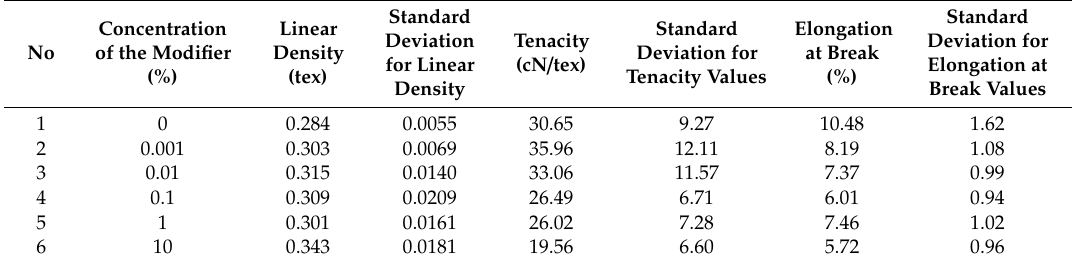
Table 1. Mechanical properties of fibers modified with luminescent polymer poly((9-carbazolyl)methylthiirane) (KMT). Standard Concentration Linear Standard Deviation Tenacity No of the Modifier Density Deviation for for Linear (cN / tex) (%) (tex) Tenacity Values Density